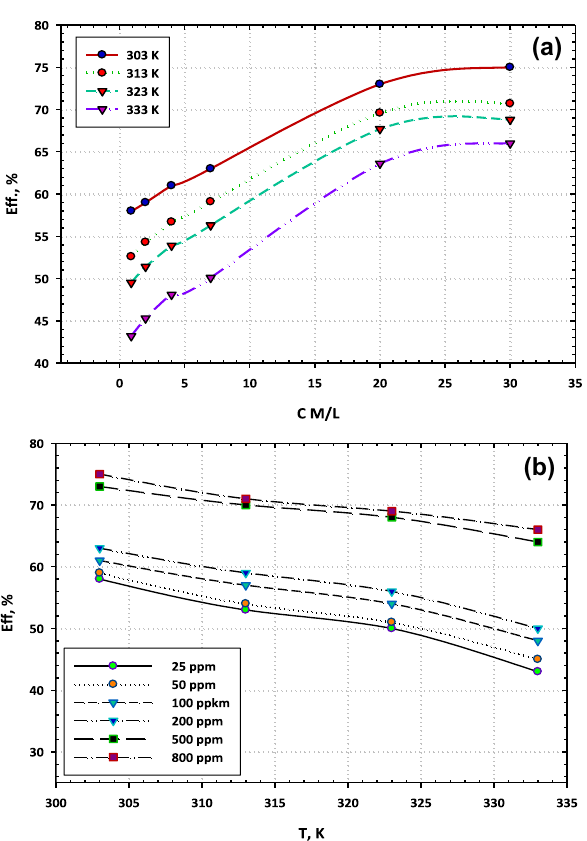
Figure 2. The dependence of the inhibition efficiency of [BMIm]TfO on the corrosion of carbon steel in 3.5% NaCl solutions as a function of ( a) temperature and ( b )